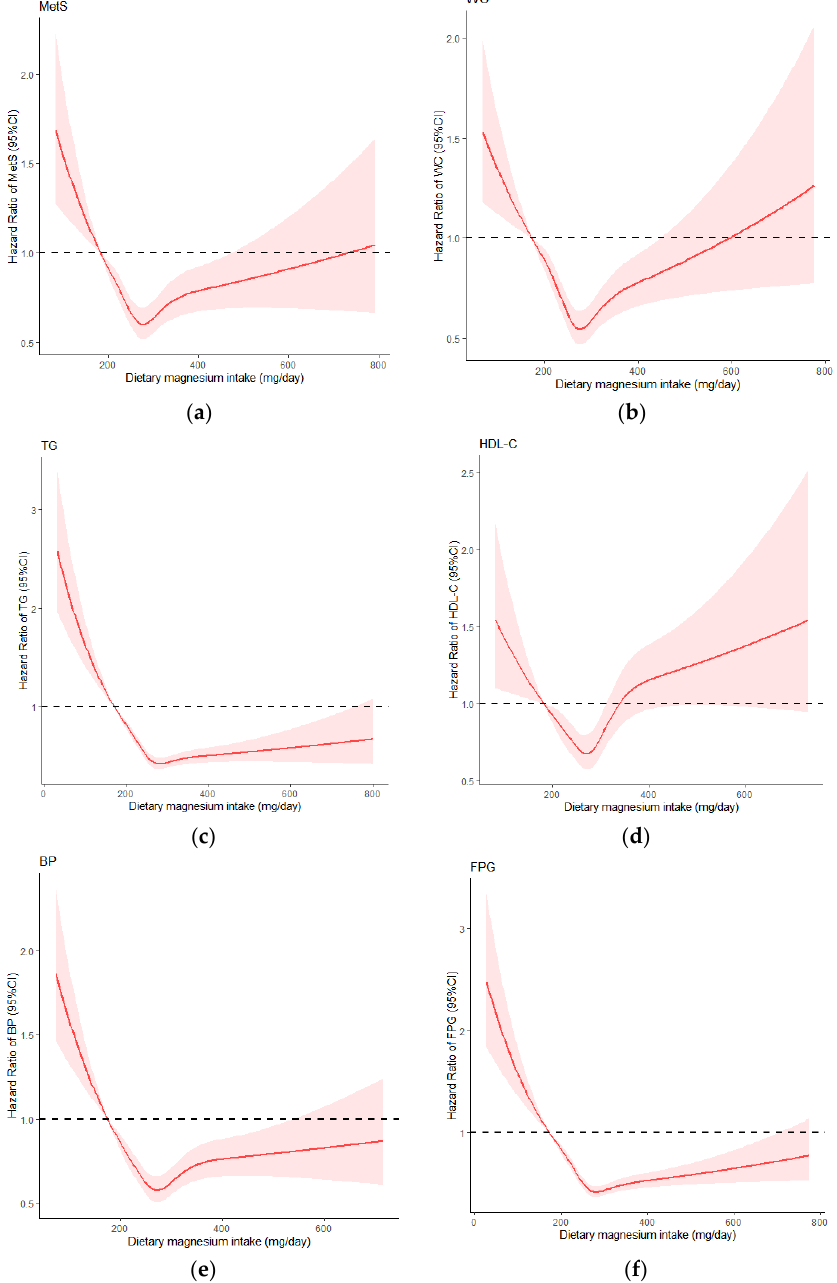
Figure 2. Dose-response relationship of dietary magnesium with MetS and its components: ( a ) MetS: metabolic syndrome; ( b ) WC: waist circumference; ( c ) TG: triglyceride; ( d ) HDL-C: high density lipoprotein cholesterol; ( e ) BP: blood pressure; ( f ) FPG: fasting plasma glucose .